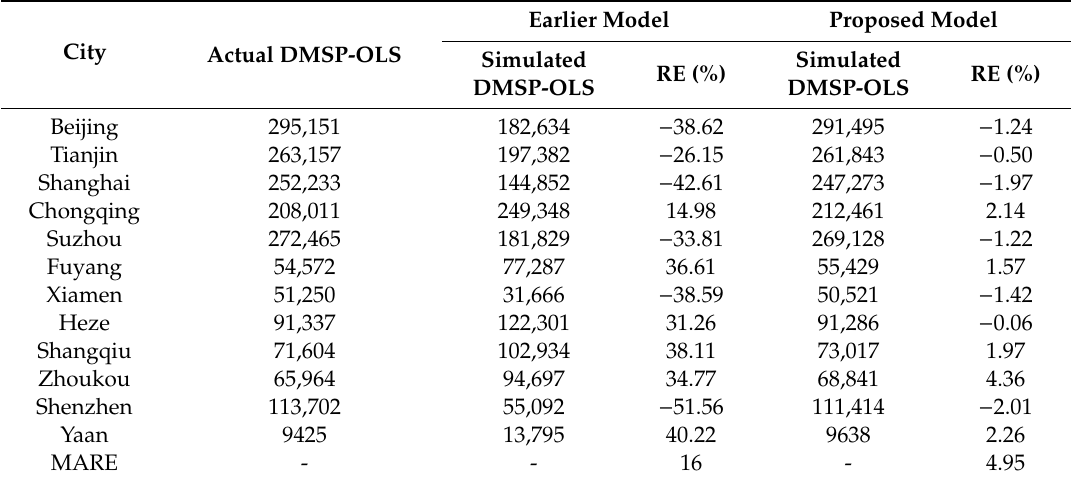
Table 2. Accuracy assessment comparison of two intercalibration models in 2012.